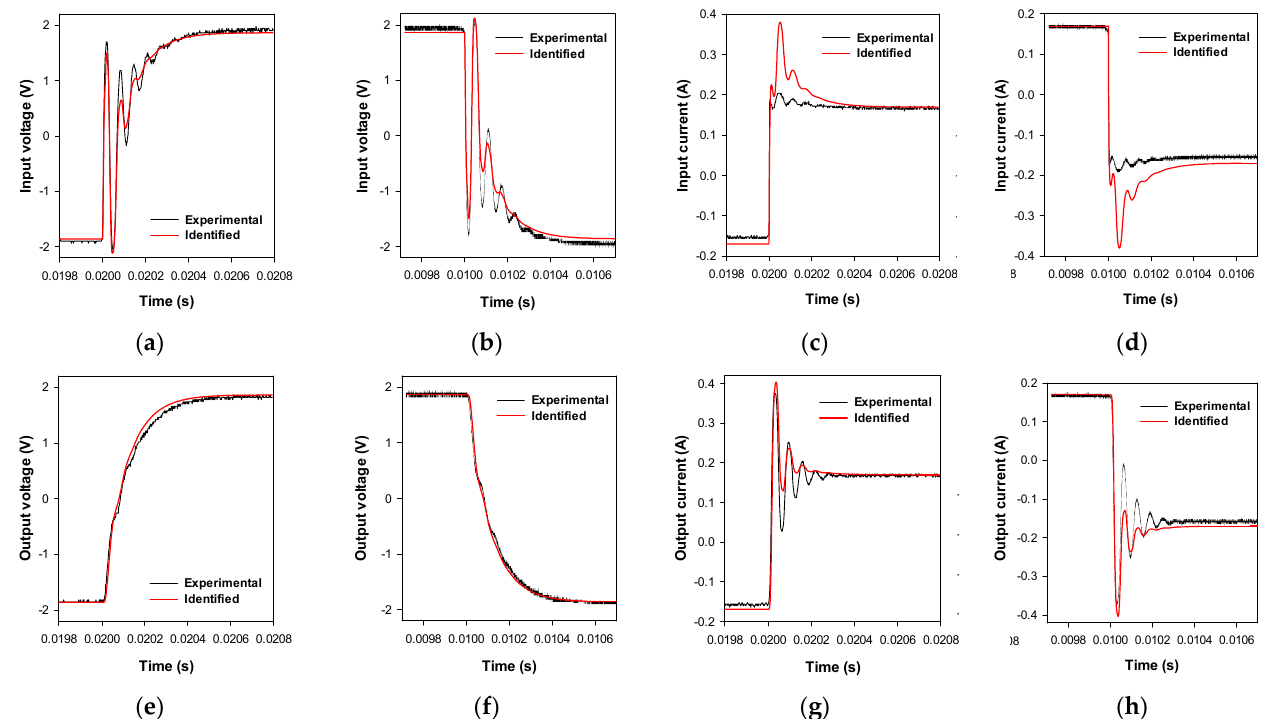
Figure 11. EMI filter. Experimental versus simulated data using the identified parameters. ( a ) Rising edge input voltage; ( b ) falling edge input voltage; ( c ) rising edge input current; ( d ) falling edge input current; ( e ) rising edge output voltage; ( f ) falling edge output voltage; ( g ) rising edge output current; ( h ) falling edge output current.